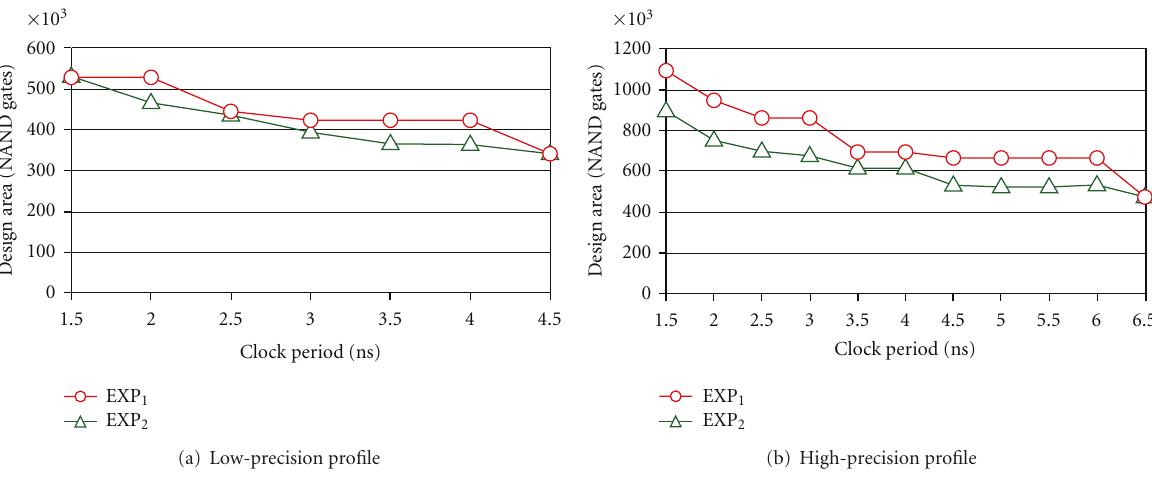
Figure 13: Area when the synthesis is constrained by a 120-clock cycle latency constraint—65 nm ASIC